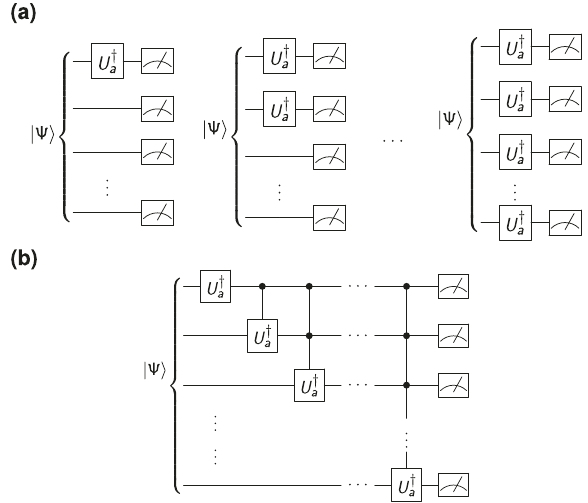
Fig. 1 Quantum circuits to implement the measurement bases. a Local measurements fL ab g . b Entangled measurements fE a g .